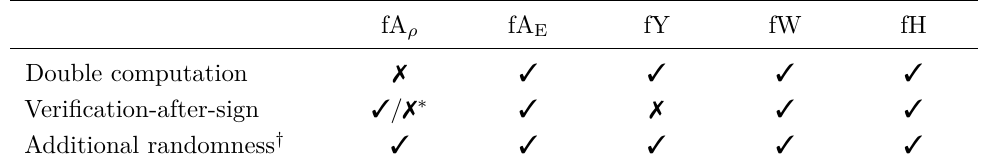
Table 6: Applicable